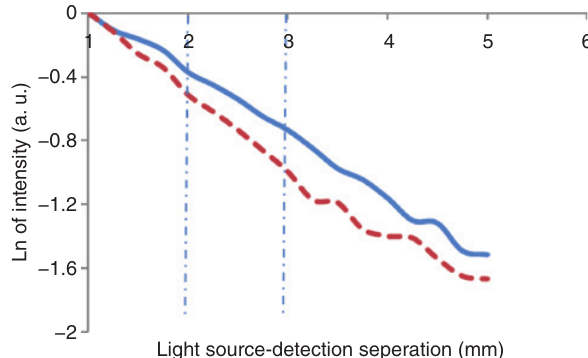
Figure 5: Representative diffusion reflection measurements of the cancerous oral tissue.